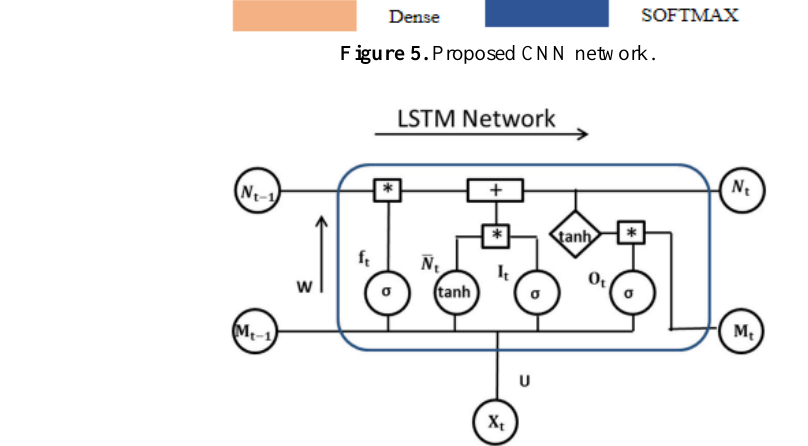
Figure 6. Representation of cell LSTM.